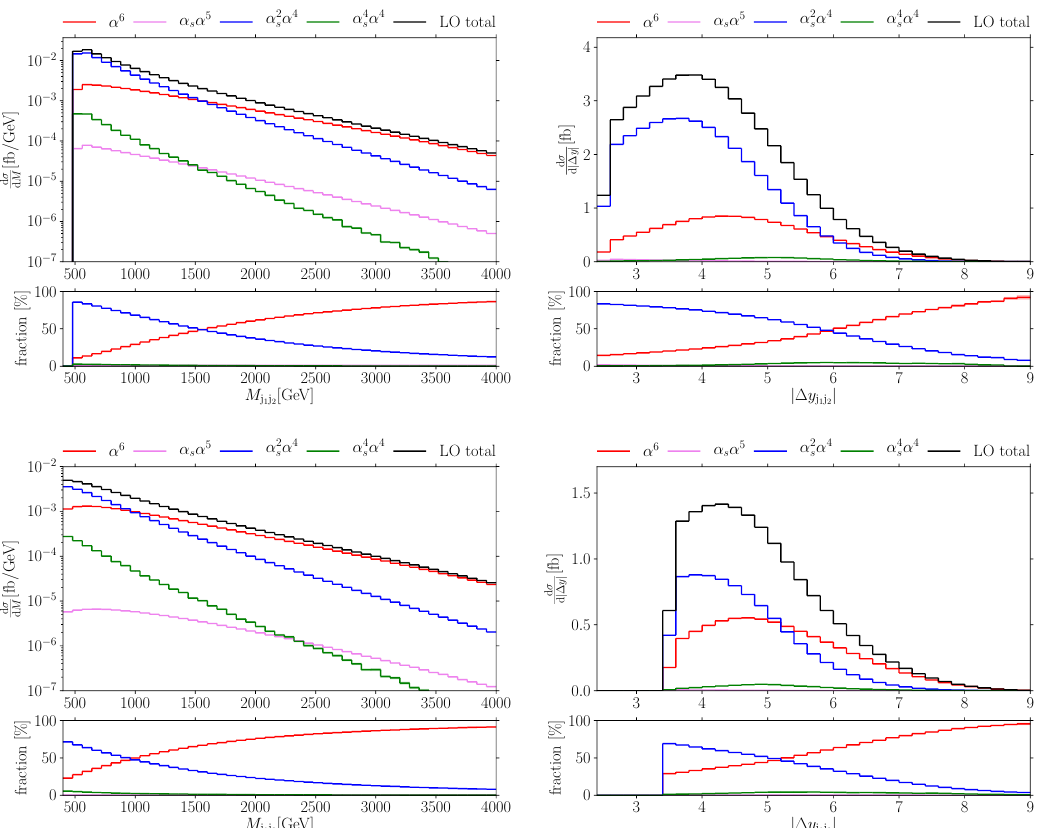
Figure 6. Differential distributions at LO in the invariant mass of the tagging jets (left) and the rapidity difference between the these jets (right) in the VBS (top) and the Higgs setup (bottom). The upper panels show the absolute EW contribution at the QCD contribution at all contributions. The lower panels show the relative contributions normalised to the sum of all contributions. Shaded bands denote integration